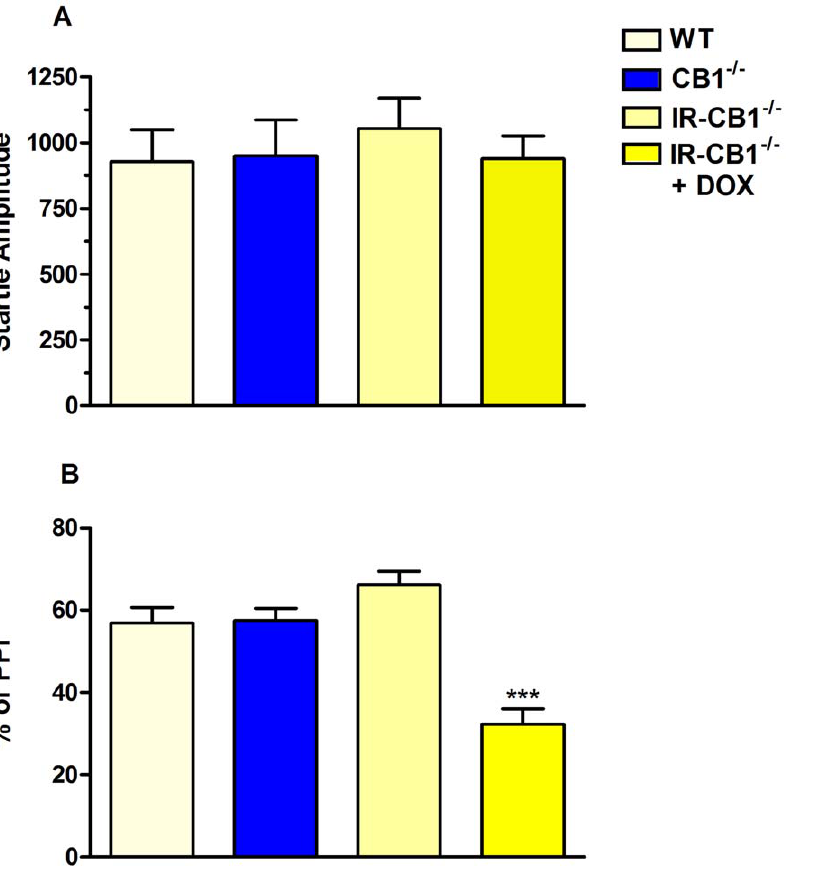
Figure 6. Startle response and percentage of PPI in IR-hCB1 -/- , CB1 -/- and WT mice: effect of Dox treatment. The startle amplitude (panel A) and % of PPI (panel B) are the mean 6 S.E.M. of WT (n=13), CB1 -/- (n=13), IR-hCB1 -/- (n=15) and IR-hCB1 -/- Dox (n=14) mice. For PPI the data are expressed as the average PPI response over the 3 prepulse intensities (see supplemental files for the figure illustrating PPI by prepulse intensity). ***P , 0.0001 IR-hCB1 -/- Dox vs all other groups (Newman-Keuls Multiple Comparison test).